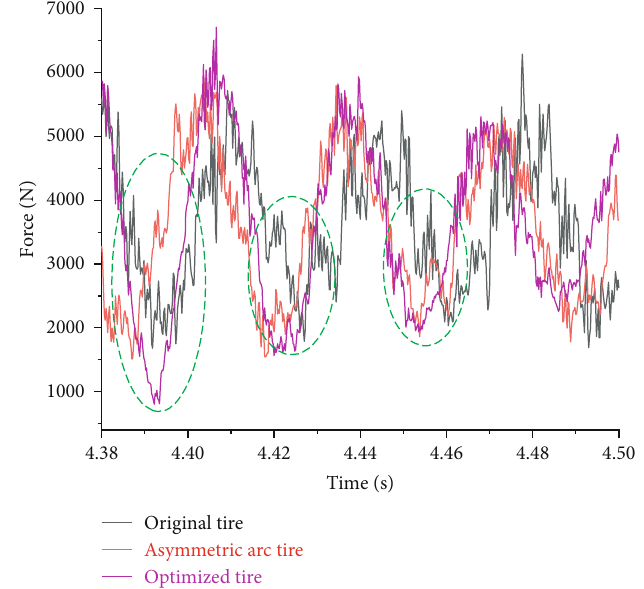
Figure 21: Comparison of the distribution of radial excitation force of three tires.